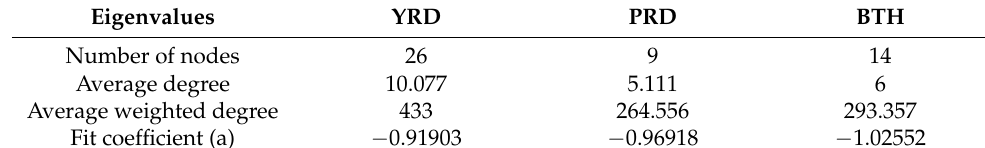
Table 2. Topological eigenvalues of check-in network of three major urban agglomerations.